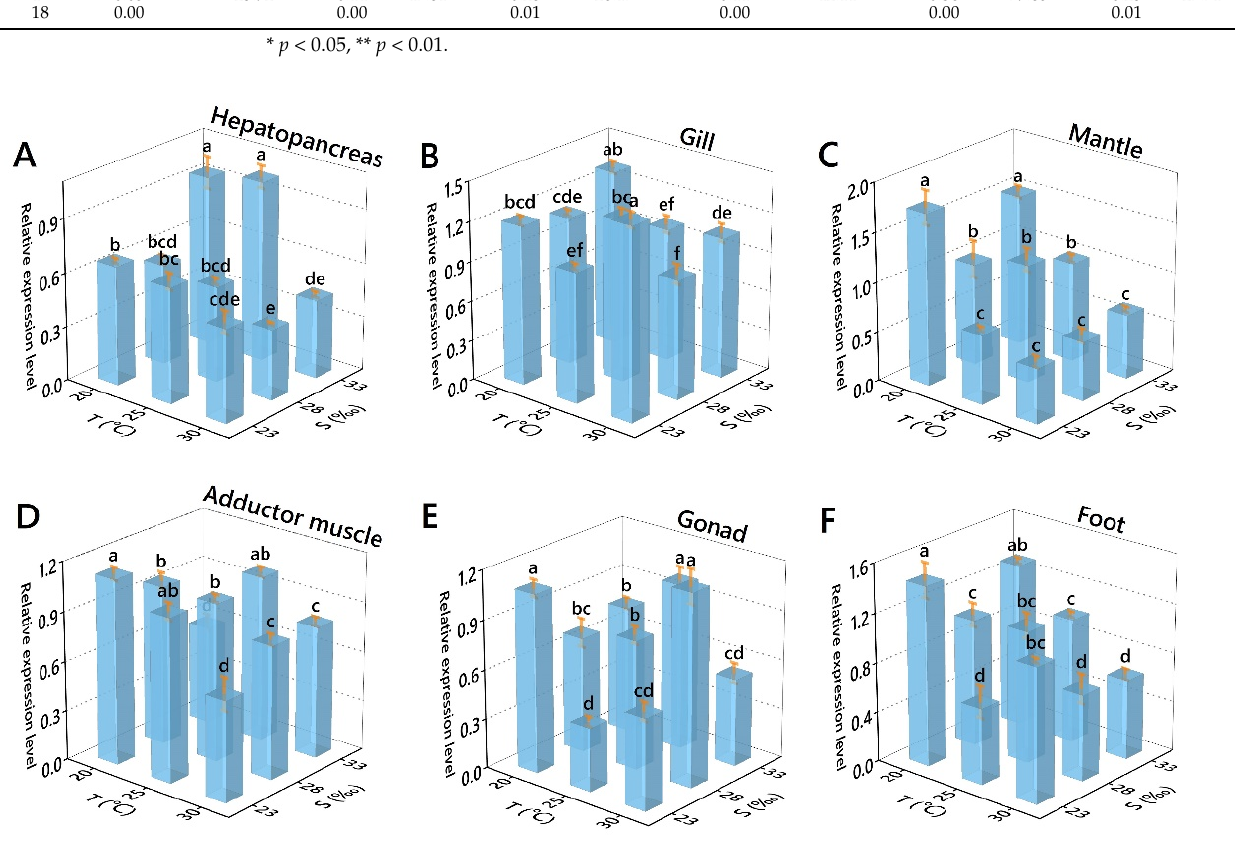
Figure 4. Effects of temperature and salinity on the GPX relative expression level of Perna viridis in different tissues. (( A ) Hepatopancrear; ( B ) Gill; ( C ) Mantle; ( D ) Adductor muscle; ( E ) Gonad; ( F ) Foot). Different letters indicate significant differences ( p < 0.05).